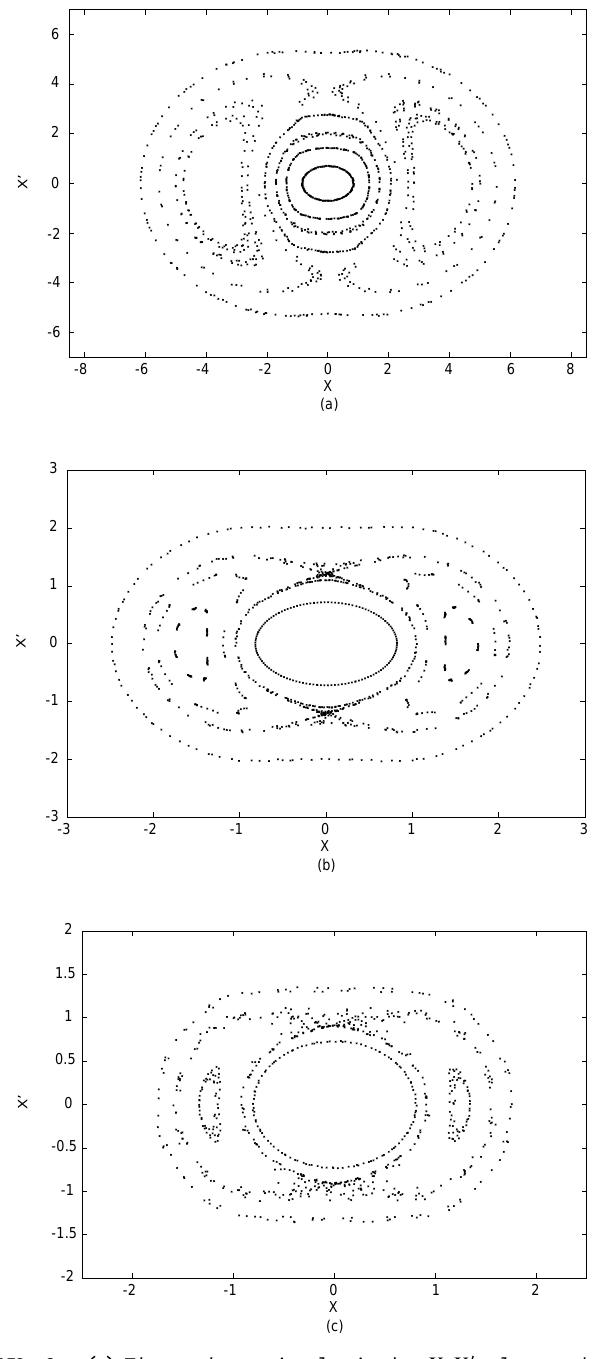
FIG. 8. (a) The stroboscopic plot in the X - X 0 plane under (a) the high mode, (b) the low mode, and (c) the quadrupole mode with a 20% initial transverse